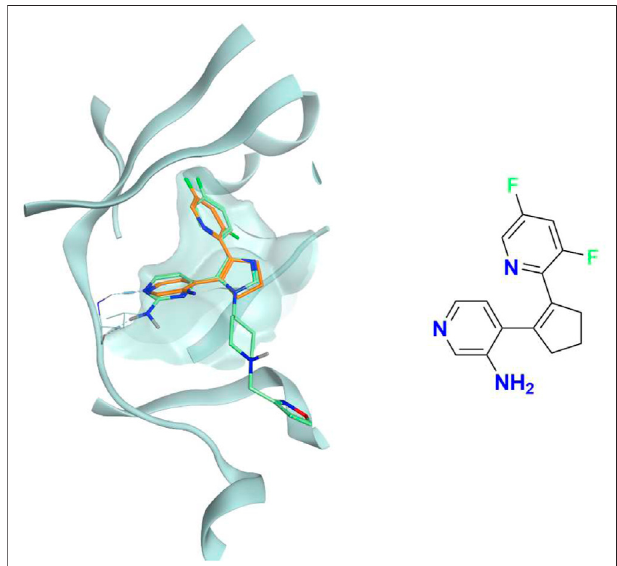
FIGURE 7 | The superposition between the docking-predicted binding mode of a high-scoring compound (MMS1) from the benchmark de novo run performed with the IFP CS scoring protocol and the reference crystal binding pose ofcompound PFOfromthestructure deposited intheProteinData Bank with accession code 4TN6. On the left part of the image, the protein kinase CK1 δ ATP binding site is reported in teal ribbon, the pose of the compound MMS1 is shown as orange sticks, while the pose of compound PFO is shown as green sticks. On the right part of the image, the chemical structure of the compound MMS1 is